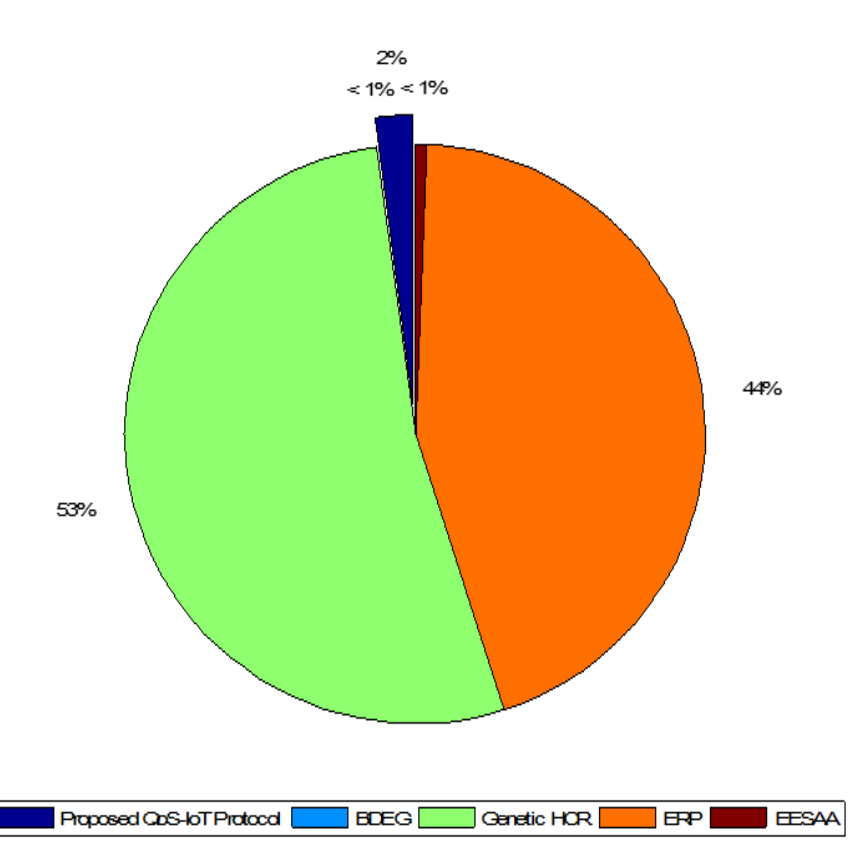
Figure 6. Comparison of variance of the protocols in network throughput.